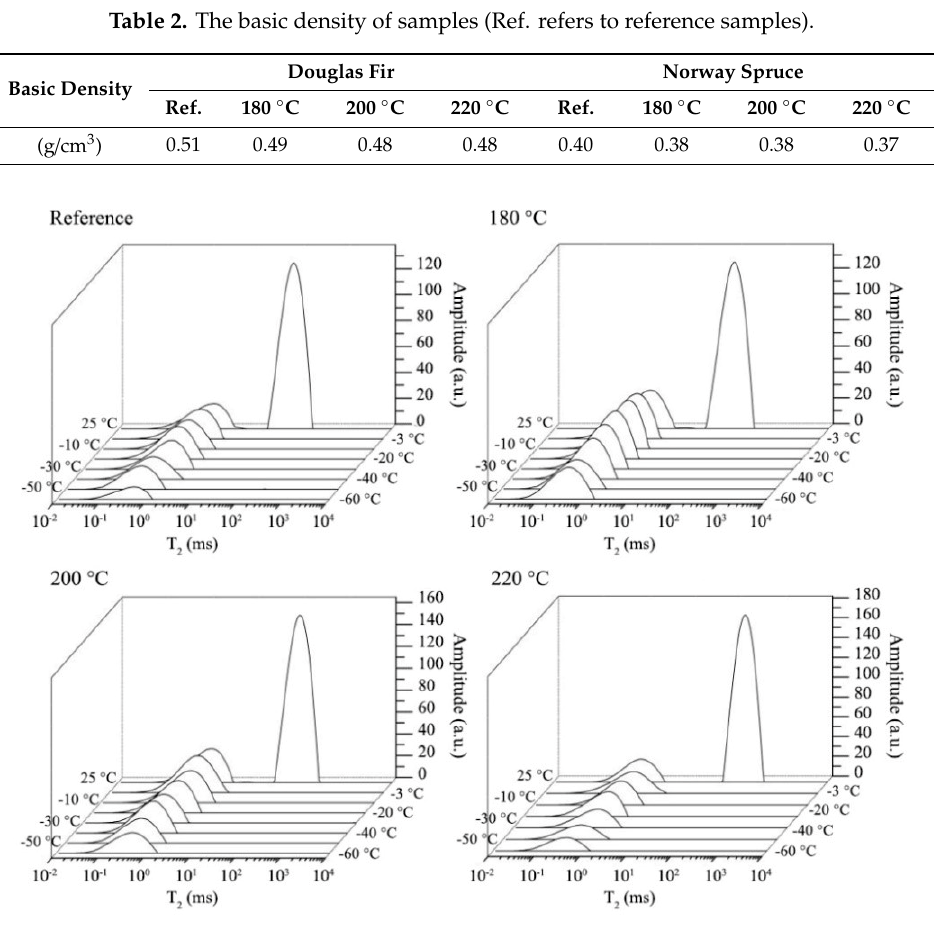
Figure 1. The T 2 distribution of Douglas fir at various temperatures.